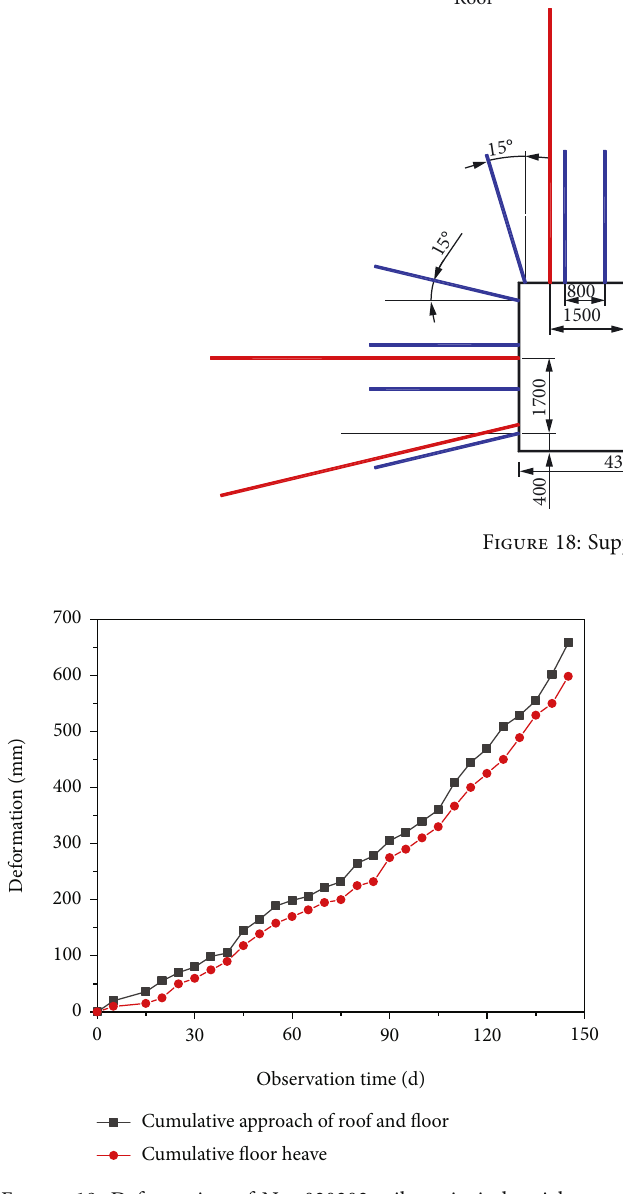
Figure 19: Deformation of No. 020202 tailgate in industrial test section during the service period